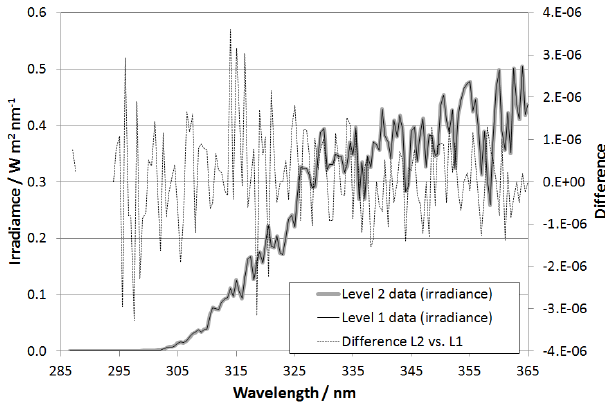
Figure 7. Examples of the Level 1 and Level 2 Brewer irradiance